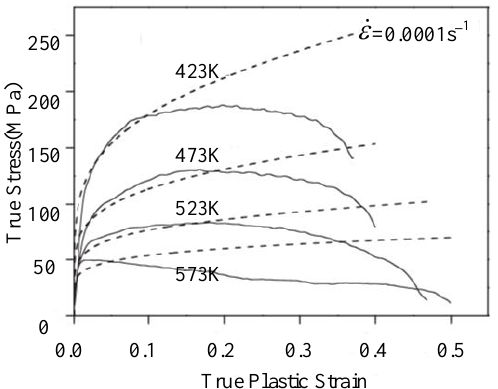
11 of 37 Figure 9. Prediction results of the KLF model under different mean particle sizes [21], ( a ) Cu; ( b ) Al. 1200 600 400 200 0 0 ( b ) Figure 10. Prediction results of the KLF model under different strain rates [21], ( a ) Cu (d = 32 nm); ( b ) Al (d = 82 nm). 2.3. Fields – Backofen (FB) Model In 1957, Fields and Backofen [22] proposed the FB model for most metal materials: n m k     =